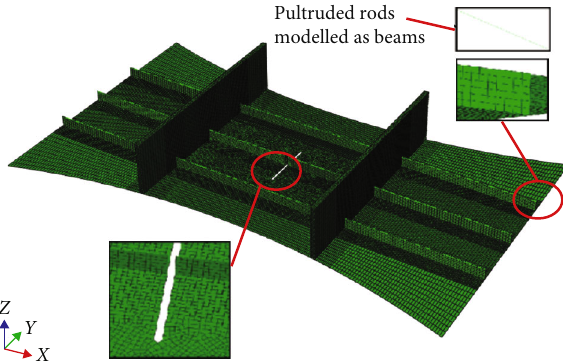
Figure 3: Damaged panel ’ s mesh model.